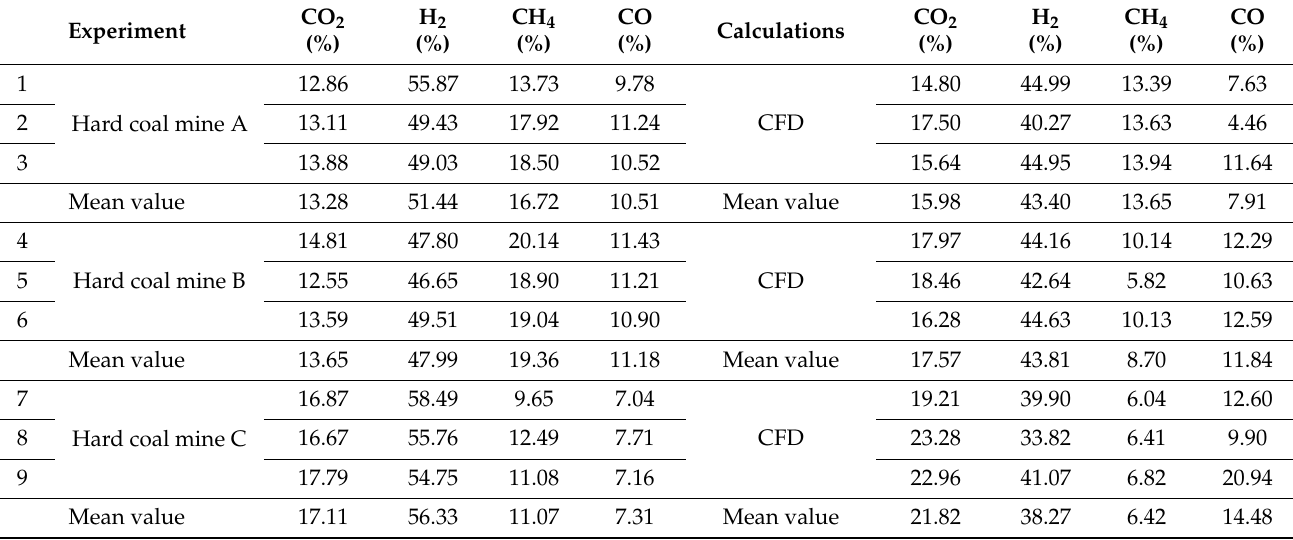
Table 7. Results of numerical and experimental